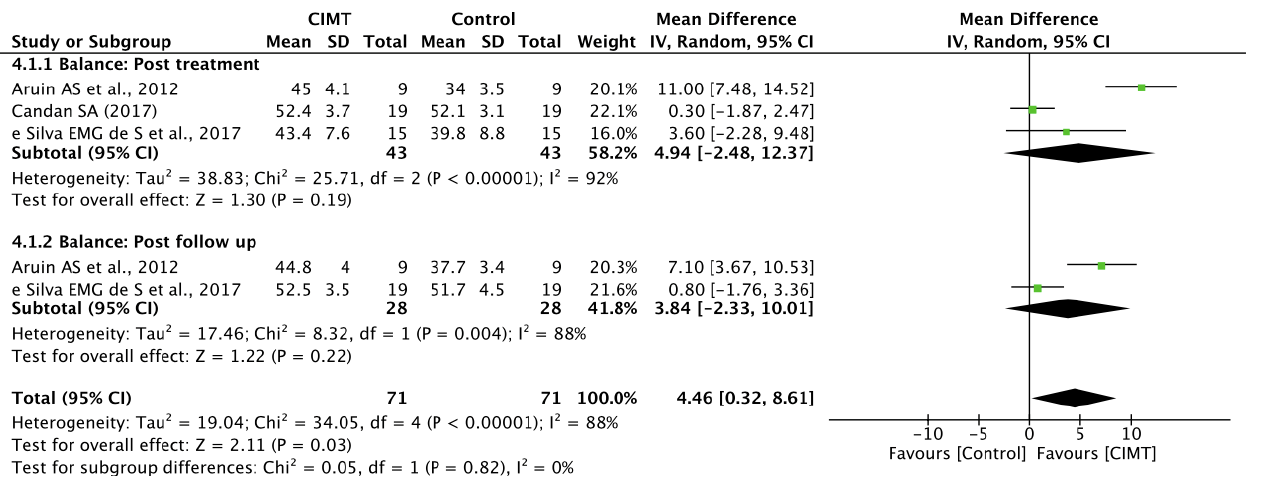
Figure 4. Balance: post-treatment and post-follow-up. (Tedla, 2022)